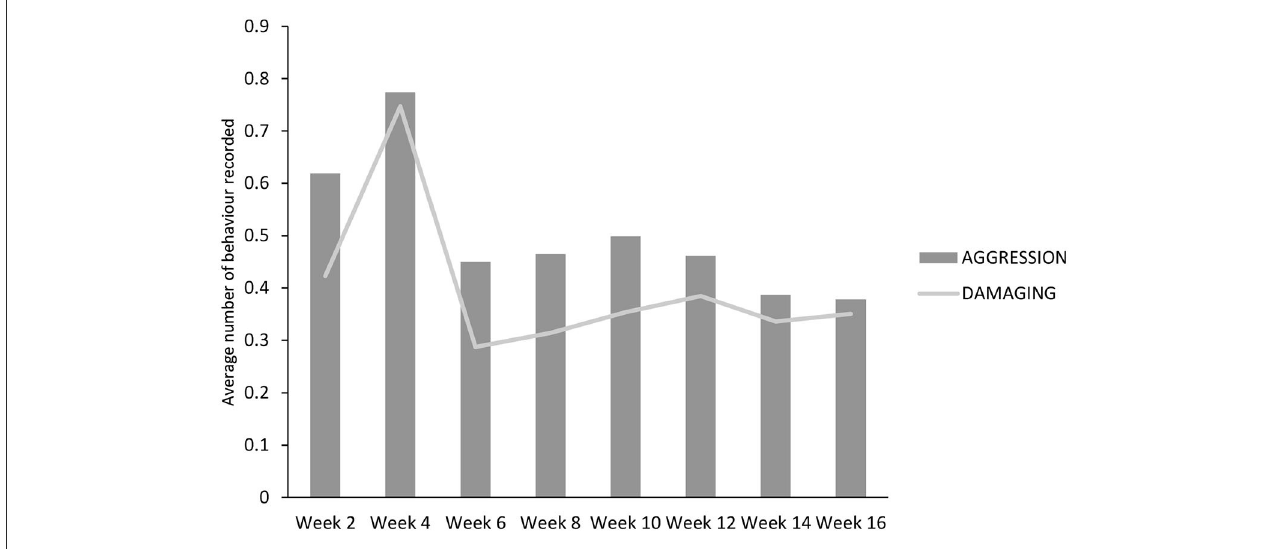
FIGURE4 Aggressive and damaging behavior performed (instances/pig/5min) during the course of the trial by both DOUBLE and SINGLE.